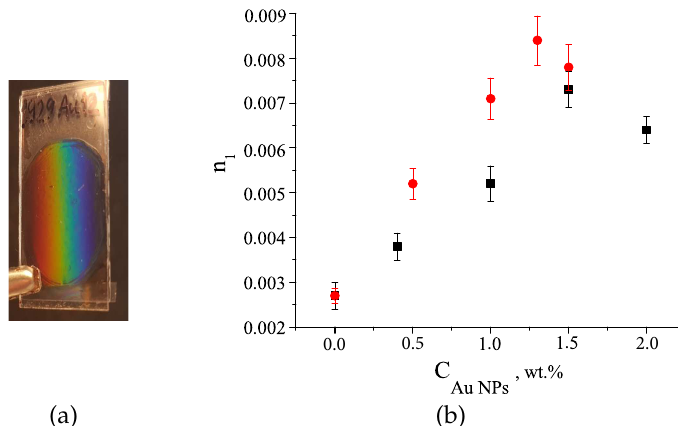
Figure 4. ( a ) Photo of the grating in the nanocomposite with Au NPs. ( b ) Maximum values of n 1 as a function of the Au NPs concentration for Au1 (black squares) and Au2 (red